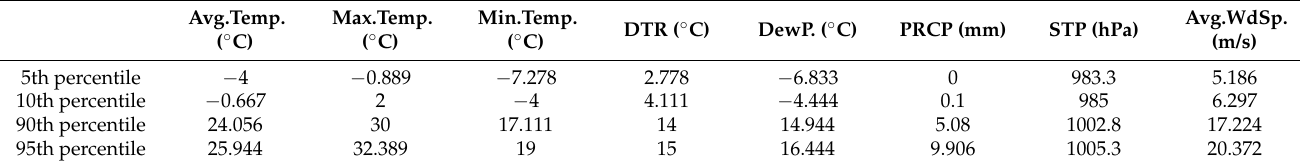
Table 1. The basis for the dichotomization of meteorological parameters. (Abbreviation: Avg.Temp.: average temperature, Max.Temp.: maximum temperature, Min.Temp.: minimum temperature, DTR: diurnal temperature range, Dew.P.: dew point, PRCP: precipitation, STP: station-level air pressure, Avg.WdSp.: average wind